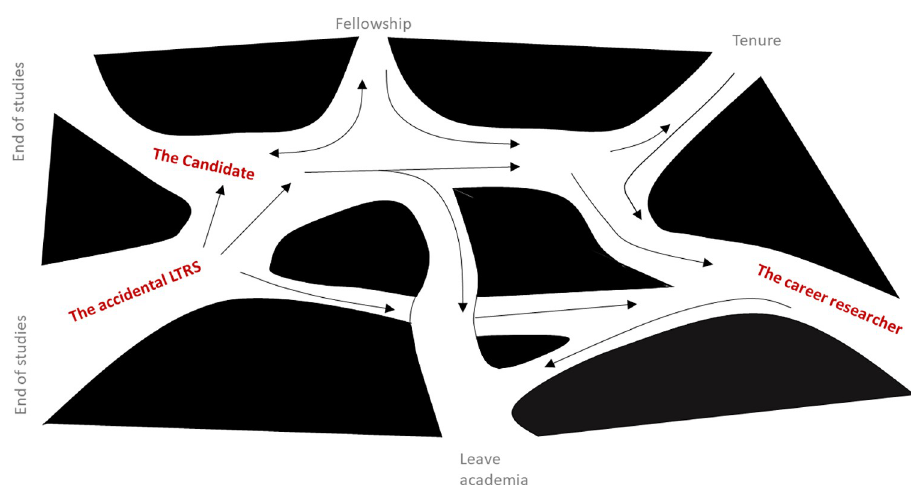
Fig 3. Schematic representation of the career paths of LTRS. Each arrow represents a path taken by at least one of the participants.